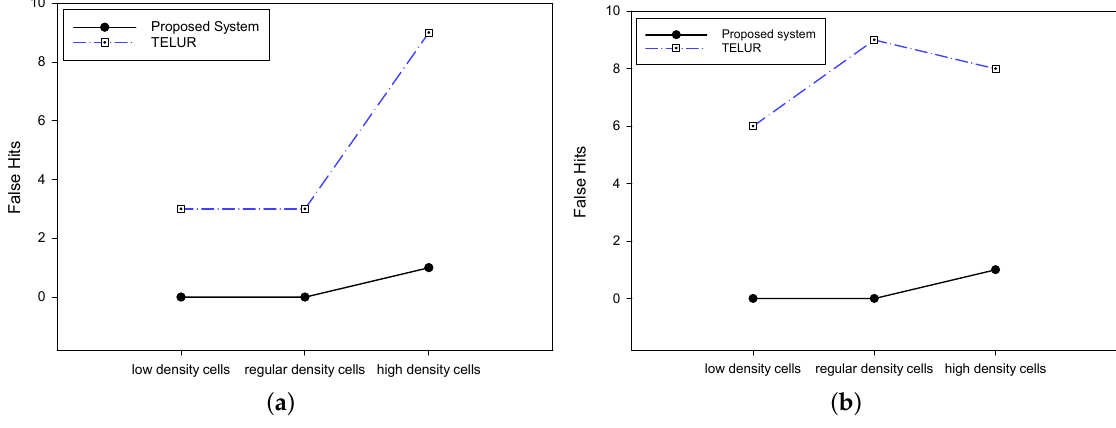
Figure 13. False hits for the path between two cells in different buildings. ( a ) Different building and same floor; ( b ) different building and different